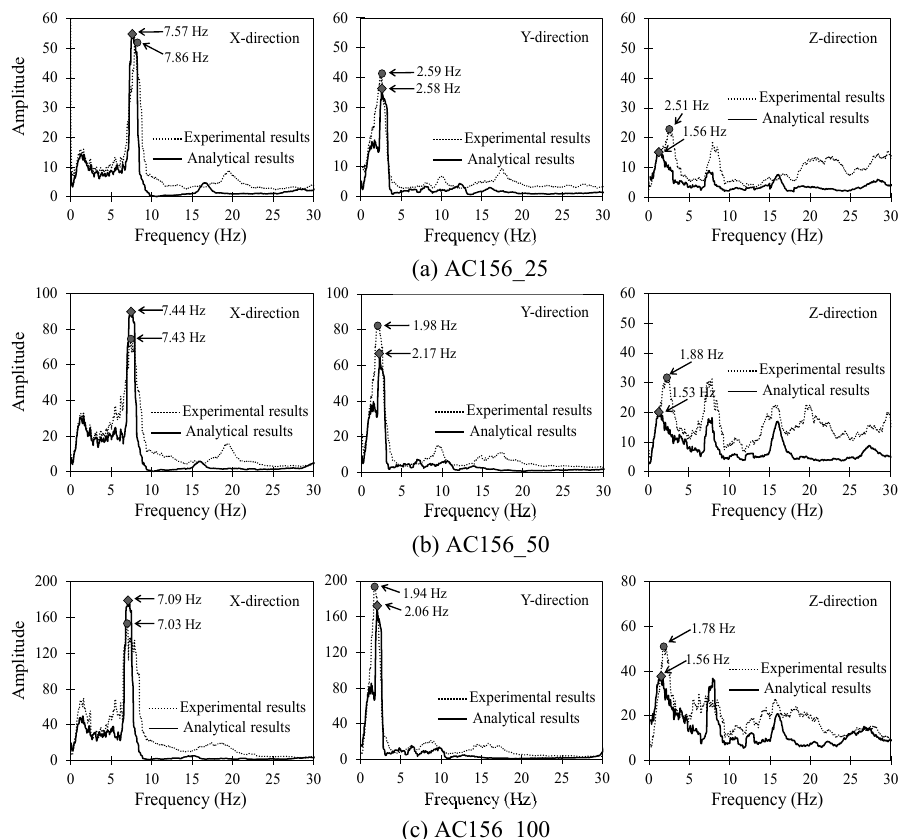
Figure 8. Comparison of analytical and experimental results after Fourier-transform (FT) analyses.